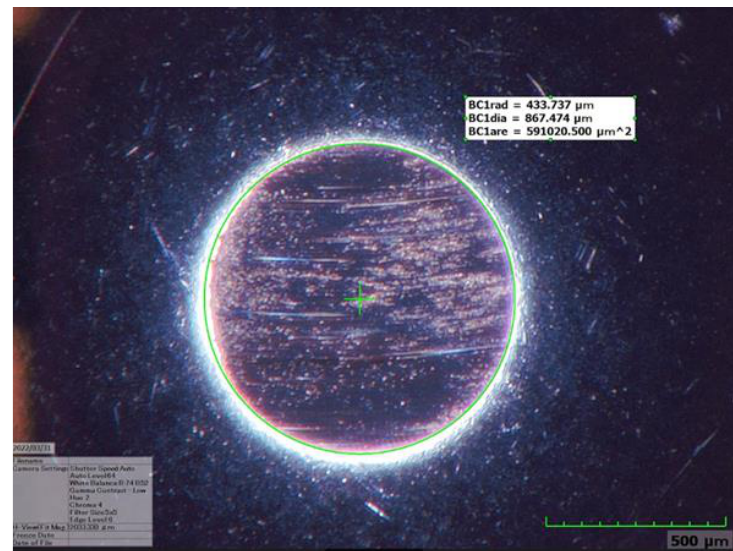
Figure A2. Ball specimen (100Cr6) worn surface after tribological tests.